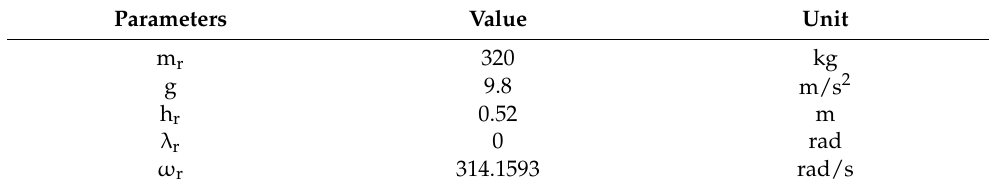
Table 9. Parameters of the prototype.